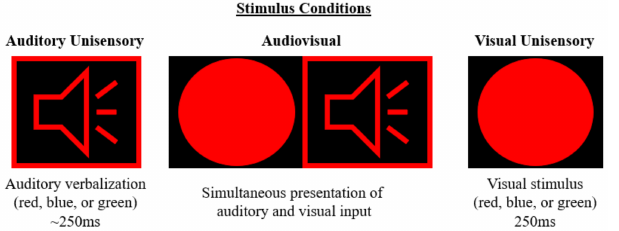
Figure 1. Visual depiction of the three unique stimulus conditions. Each condition was representative of the colour red, blue, or green. The audiovisual condition was always semantically congruent. To measure MSI, a two-alternative forced-choice discrimination task was utilised that consisted of three unique stimuli that were semantically congruent. For example, a female verbalisation of the word “red” was paired with a red circle, or verbalisation of the word “blue” was paired with a blue circle. Similar paradigms have been used previously